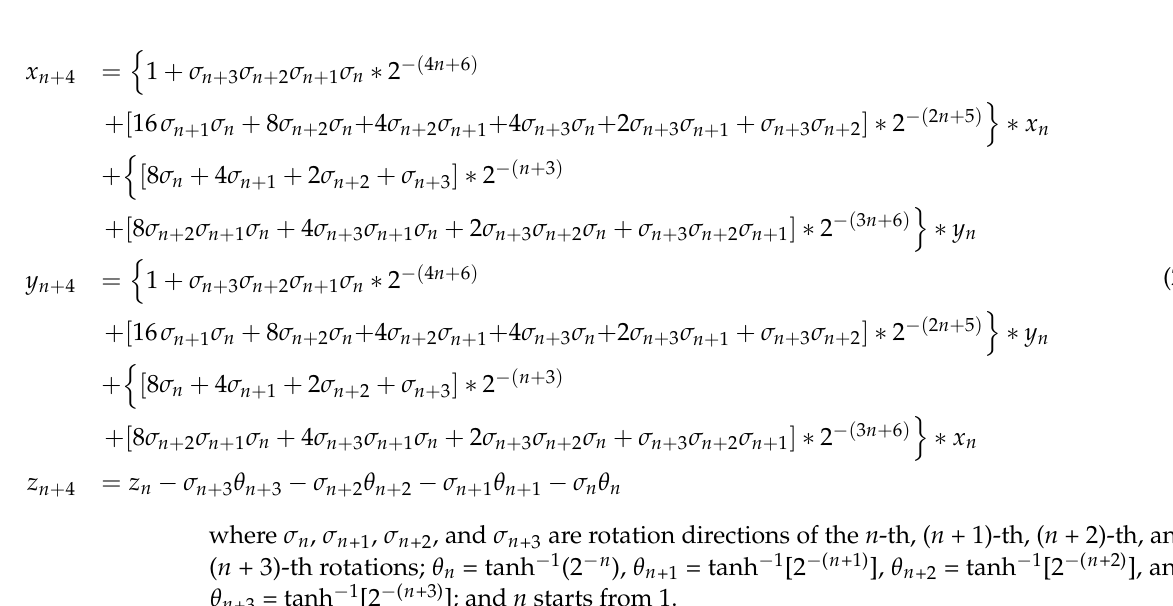
Table 1. Corresponding iterative formula of y n +4 .